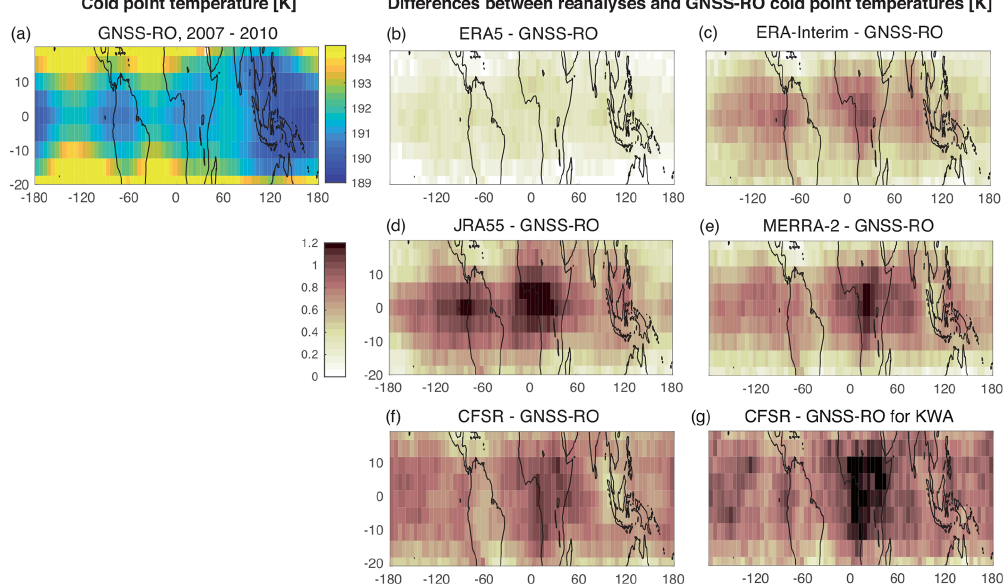
Figure 7. Latitude–longitude distributions during 2007–2010 of annual mean GNSS-RO cold point temperatures (a) and differences between cold point temperatures from individual reanalyses and those from GNSS-RO (b–f) . Differences between CFSR and GNSS-RO cold point temperatures for time periods of high Kelvin wave activity (g)